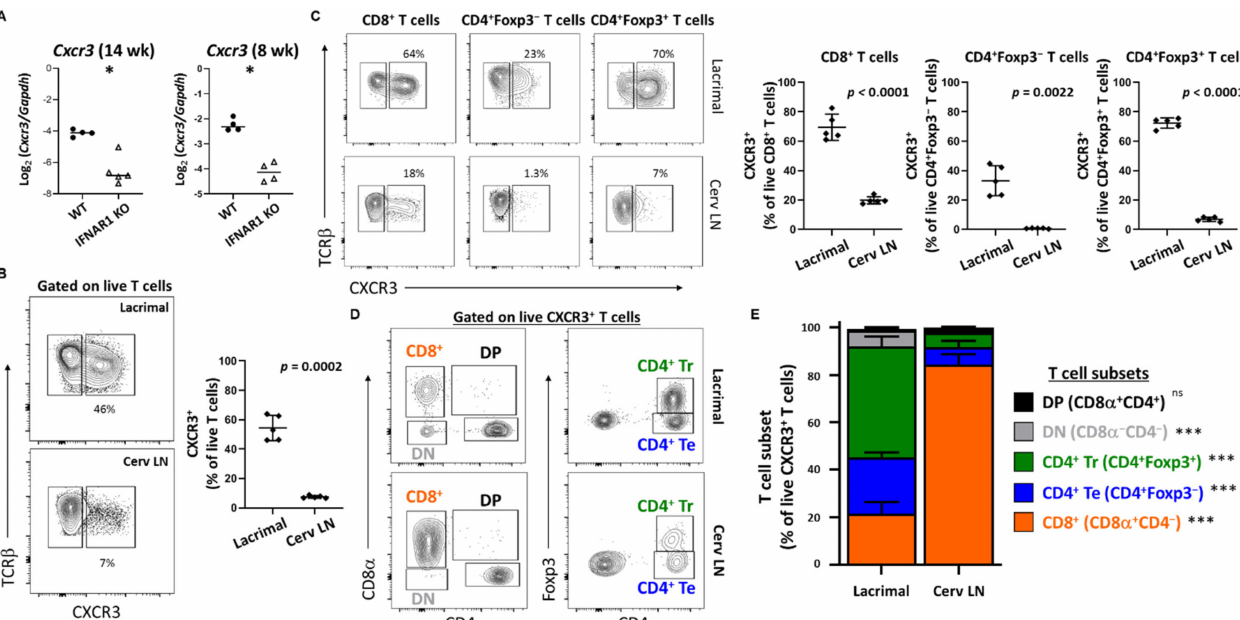
Figure 5. CXCR3 + T cells are enriched in lacrimal glands of WT NOD mice. ( A ) Quantitation of Cxcr3 in lacrimal glands of 14-week-old (left) and 8-week-old (right) WT and IFNAR1 KO NOD mice, shown as Log-transformed ratio normalized to Gapdh . Symbols represent individual mice ( n = 4–5 per group), lines are medians. p -values by Mann-Whitney test with * p < 0.05. ( B ) Representative contour plots gated on live T cells (TCR β + CD19 − singlets) isolated from lacrimal glands (top) or cervical lymph nodes (Cerv LN, bottom) of WT NOD mice. Numbers indicate % CXCR3 + cells. The graph (right) depicts the cumulative proportion of CXCR3 + cells among live T cells in lacrimal glands or cerv LNs from WT NOD mice ( n = 5). Symbols represent individual mice, lines are means, and error bars are standard deviation. p -value by paired t-test. ( C ) Representative contour plots demonstrate CXCR3 + populations of live T cell (TCR β + CD19 − ) subsets gated as indicated above graphs, isolated from lacrimal (top) or cerv LN (bottom). Graphs depict cumulative data represented in the contour plots from multiple WT NOD mice ( n = 5). Symbols, lines, error bars, and p -values as in (B). ( D ) Representative contour plots gated on live CXCR3 + T cells (TCR β + CD19 − ) showing the different T cell subsets further quantified in ( E ). ( E ) Stacked bar graphs demonstrating the proportions of different T cell subsets represented in ( D ) that make up the CXCR3 + T cell population represented in ( B ). Each stacked bar represents the mean % of CXCR3 + cells within the indicated T cell subset with error bars representing standard deviation ( n = 5 mice). p -values for comparisons of each subset between lacrimal and cerv LN by paired t-test indicated in key with *** p < 0.001, ns p > 0.05. DN, double negative; DP, double positive; Te, effector T cells; Tr, regulatory T